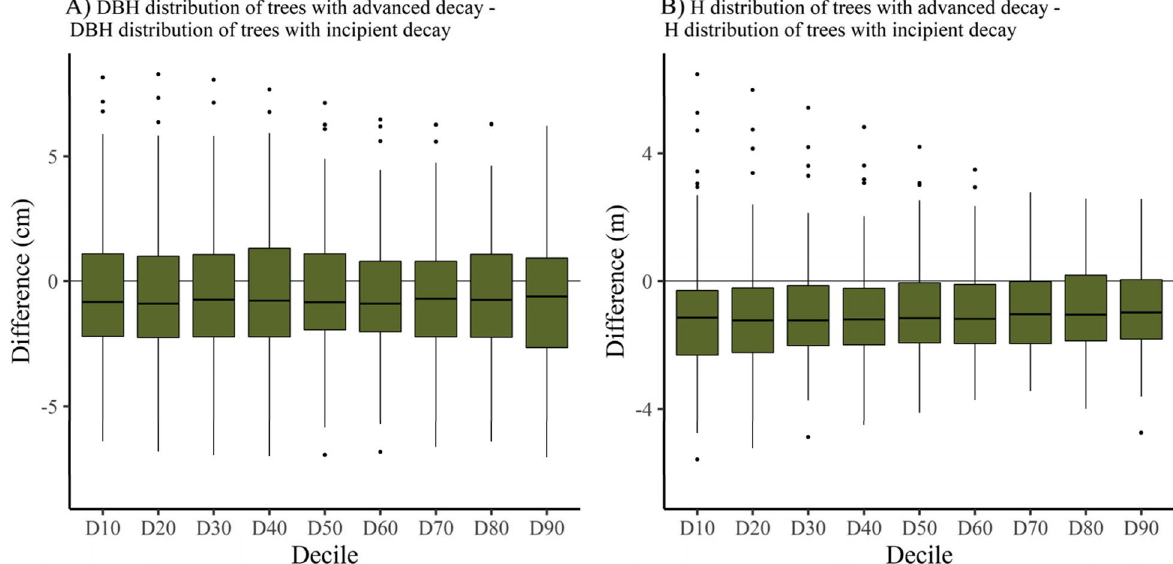
Fig. 5 A Differences in decile values associated with diameter at breast height (DBH) distributions of trees with advanced and incipient decay in the harvested segments and B a corresponding comparison in terms of height (H) distributions